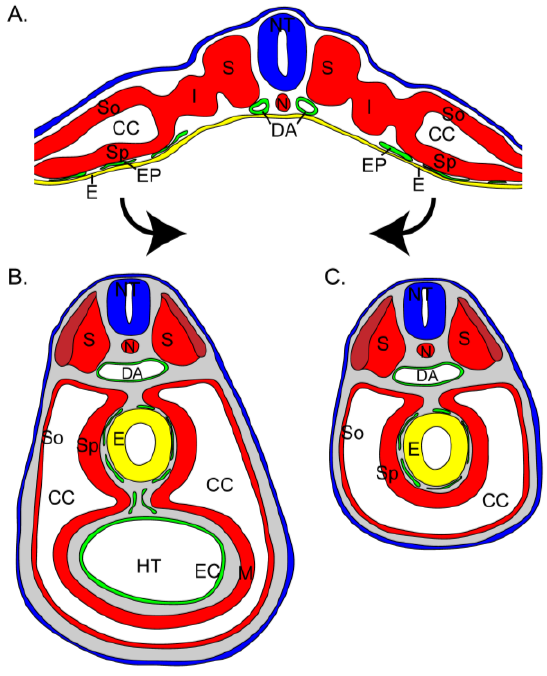
Figure 4. Heart and gut tube formation. ( a ) Schematic of a transverse section through the posterior region of a HH14 chick embryo demonstrating the relationship of the splanchnic mesoderm and endoderm prior to lateral folding. The lateral plate mesoderm is divided to form the somatic (So) and splanchnic mesoderm (Sp) with an intervening coelomic cavity (CC). An endothelial plexus (EP, green) resides between the splanchnic mesoderm and endoderm (E, yellow). Lateral folding (arrows) will unite the somatopleure and splanchnopleure ventrally. ( b ) In the anterior region of the HH14 embryo, lateral folding has already been completed. The endoderm has been excluded from the heart tube (HT) and cells of the endothelial plexus have formed the endocardial (EC) lining of the heart tube lumen. Dorsal to the heart tube, the endoderm of the gut tube remains invested by the endothelial plexus and splanchnic mesoderm. ( c ) Posterior to the heart tube in a HH18 chick embryo, the gut tube is the only structure within the coelomic cavity and includes endoderm, the endothelial plexus, and splanchnic mesoderm. DA, dorsal aorta; I, intermediate mesoderm; N, notochord; NT, neural tube; S,